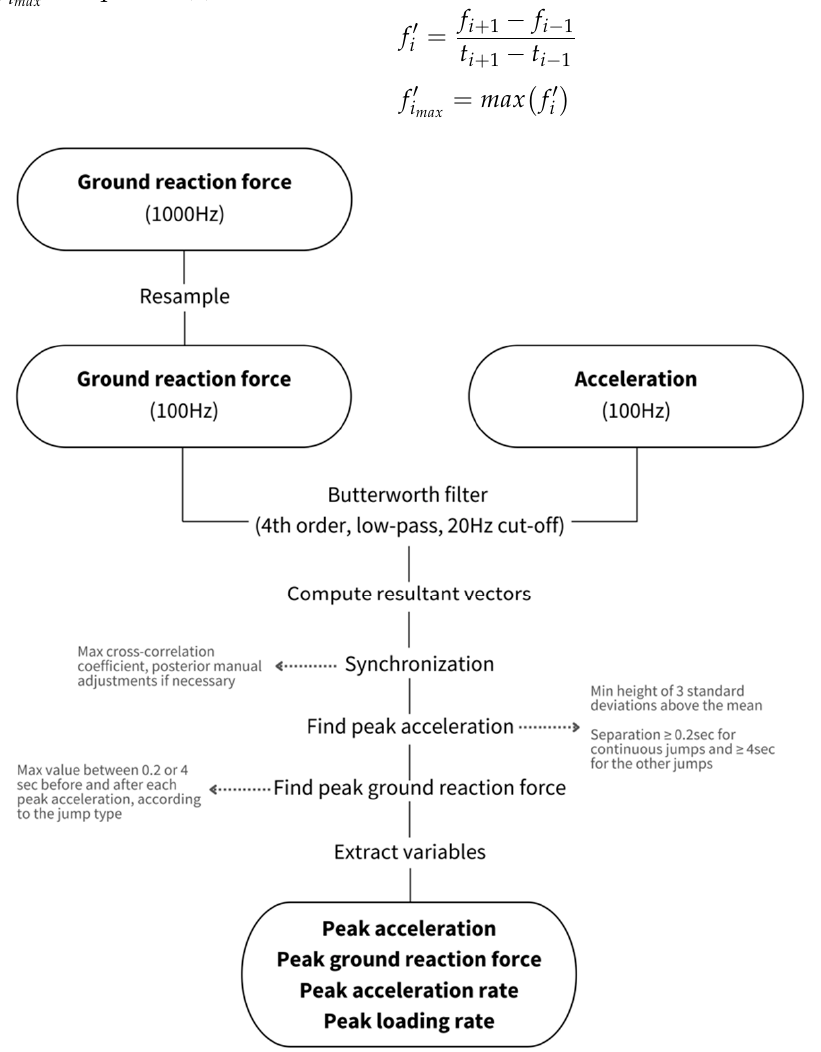
Figure 4. Flowchart showing all steps of the data processing.